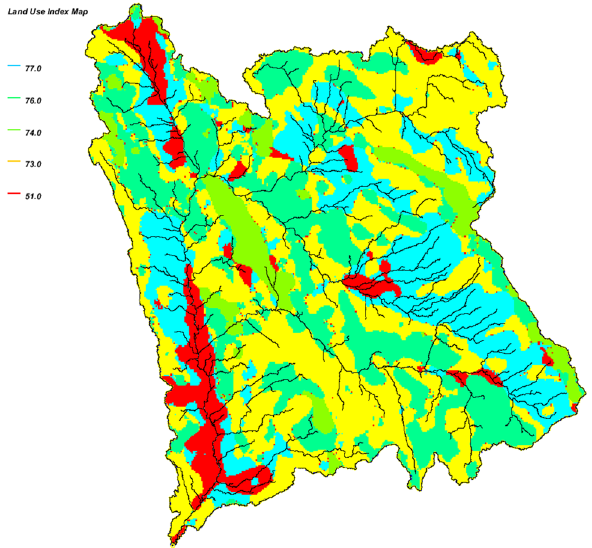
Fig. 10 Distributed model of land use in the watershed area used in the 2-D routing of surface overland